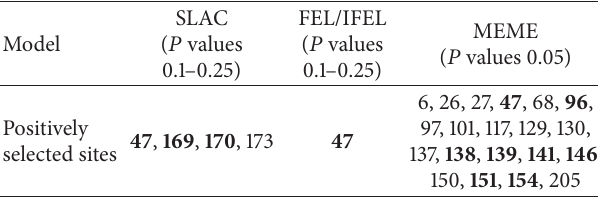
Table 1: Selection pressure estimates for VP1 region of 319 FMDV serotype Asia 1 strains. Antigenically critical sites and significant mutation sites are in